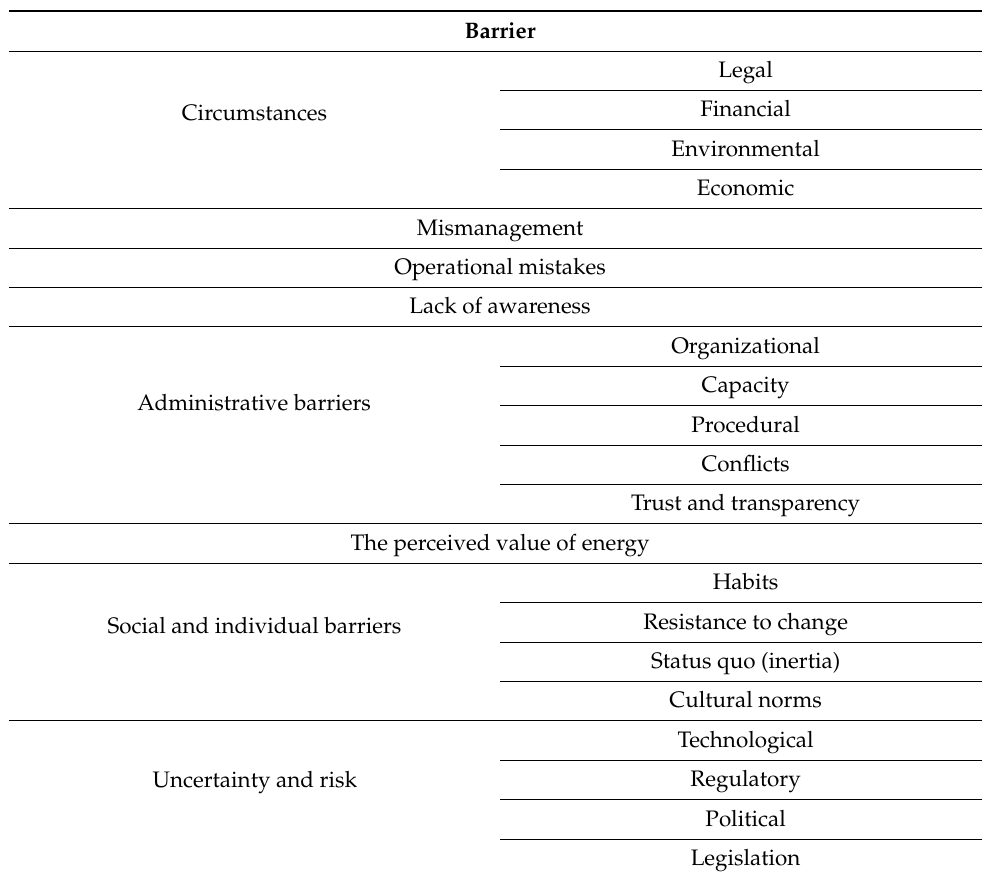
Table 3. Barriers for formal social units (source: Biresselioglu et al.